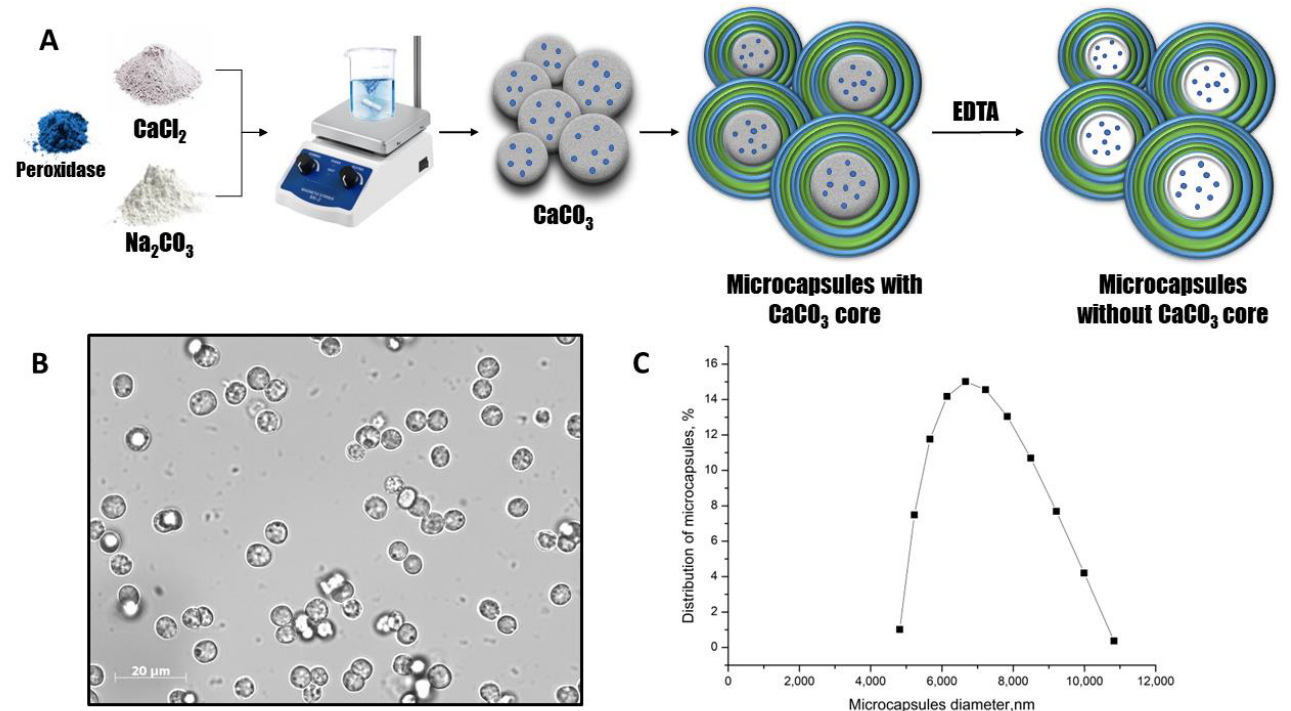
Figure 1. The scheme of the peroxidase encapsulation in polyelectrolyte microcapsules ( A ). The optical microscopy images of PMC ( B ). The PMC diameter distribution function ( C ).